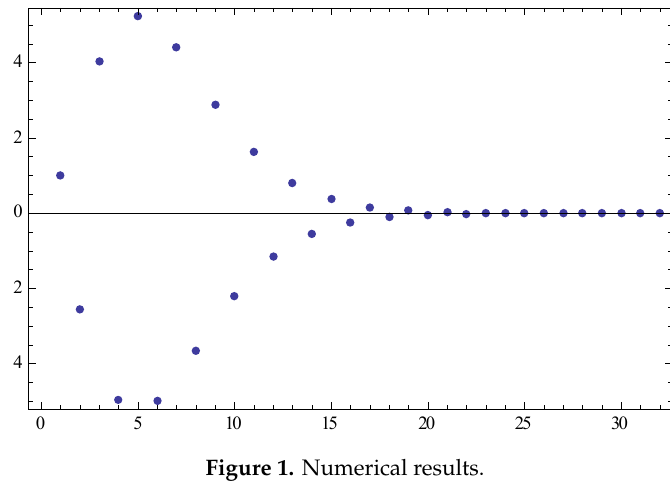
Figure 1. Numerical results.